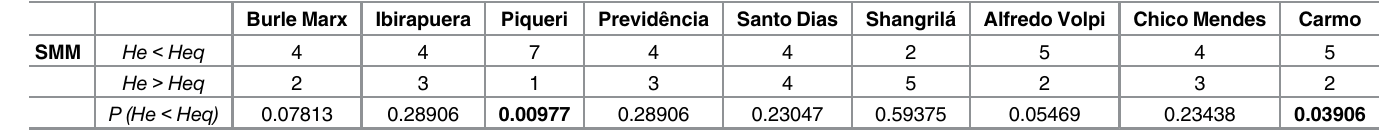
Table 3. Aedes fluviatilis heterozygosity